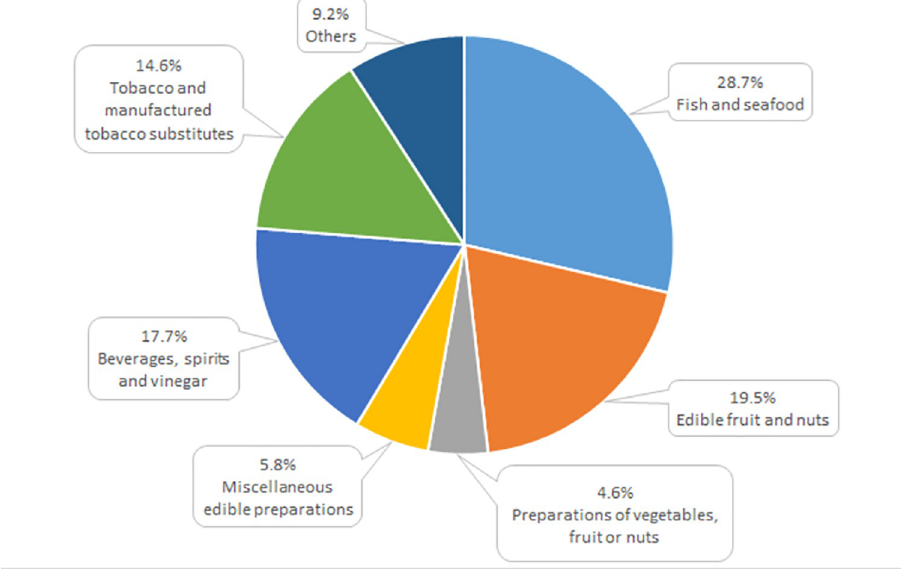
Fig 8. Commodity structure of Poland’s import of agri-food products from the US in 2021 (%). Source: [13], the authors’ elaboration.